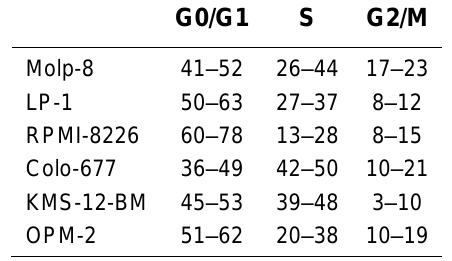
Values are expressed in percentage of total viable cell number (100%). Range of four independent